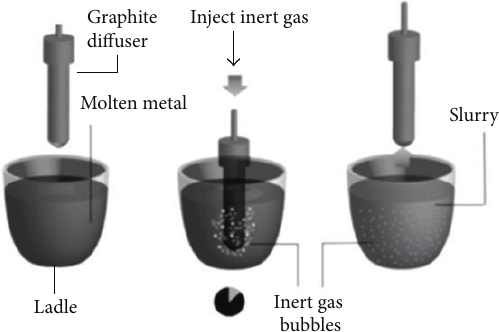
Figure 22: Schematic diagram of the steps of the GISS method [50].